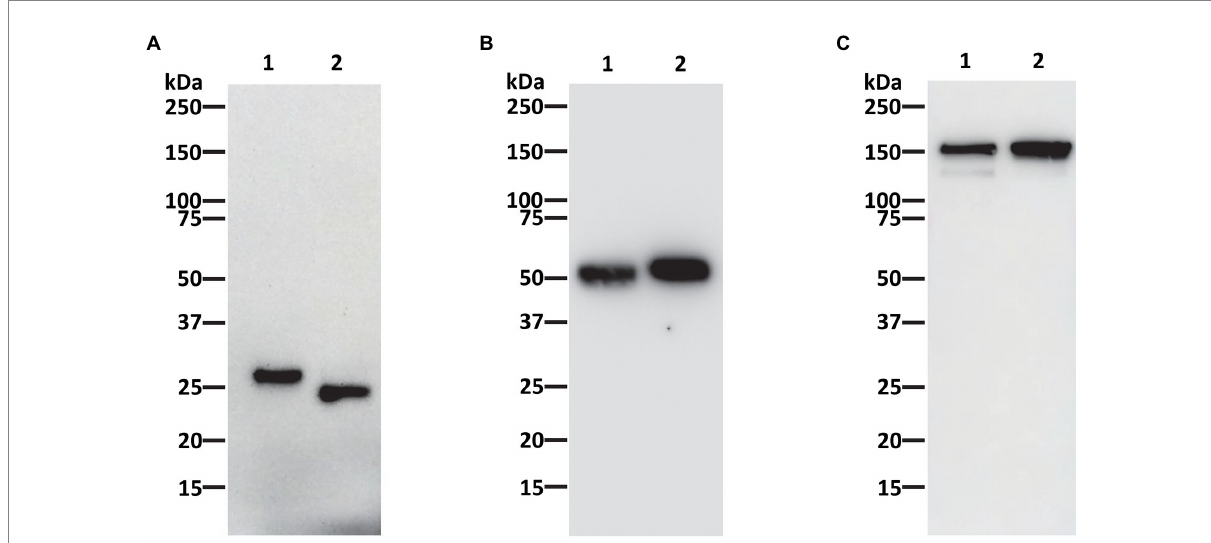
FIGURE 3 Western blot analysis of 4H2 IgG purified from Nicotiana benthamiana leaves. Purified recombinant P-4H2 IgG was separated under reducing (A,B) or non-reducing (C) conditions by SDS-PAGE and proteins was transferred to PVDF membranes. Proteins were then detected with antibodies specific for human kappa chain (A,C) or human gamma chain (B) to verify protein identity and assembly. Lane 1, Humanized P-4H2 IgG (1 μ g per lane in A , 0.5 μ g per lane in B,C ), Lane 2, Human kappa IgG isotype reference standard (1 μ g per lane in A , 0.5 μ g per lane in B,C ).